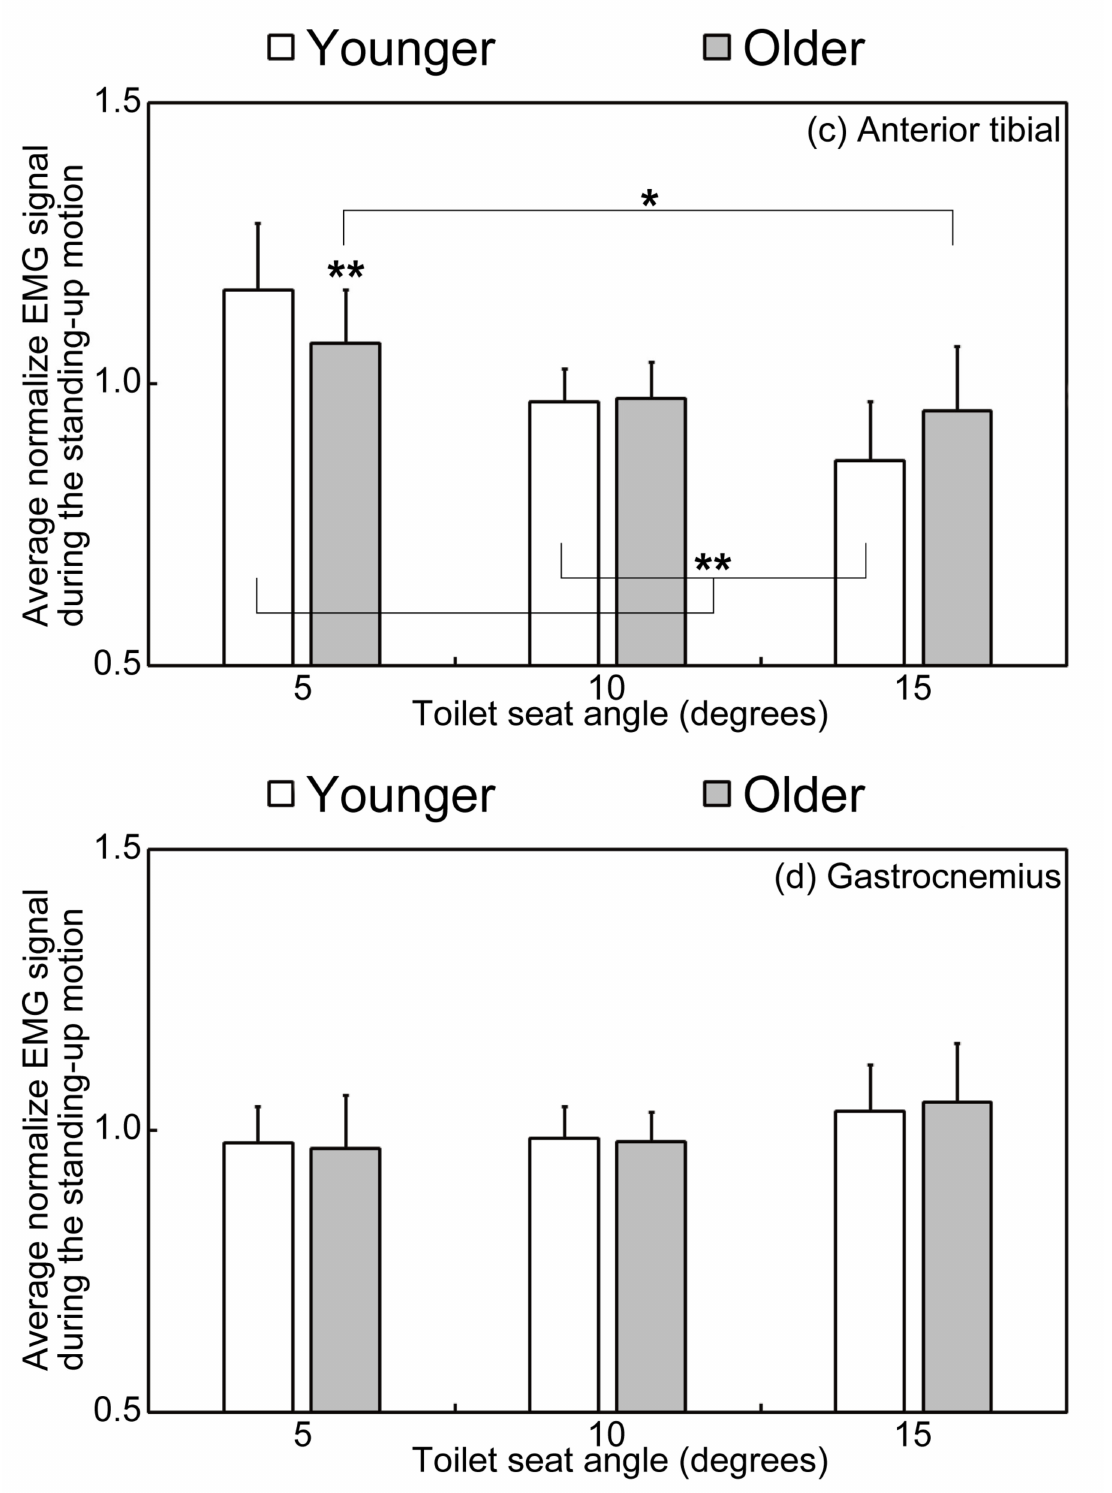
Figure 7. Comparison of average peak EMG amplitudes during the standing-up motion according to toilet seat angle. ( a ) Erector spinae; ( b ) rectus femoris; ( c ) tibialis anterior; and ( d ) gastrocnemius. Vertical lines denote the standard error of the mean. Brackets indicate a statistically significant difference (based on the Bonferroni test) by toilet seat angle. Asterisks indicate a statistically significant difference (based on the Bonferroni test) between younger and older participants. Bonferroni multiple comparison test (**) p < 0.01, and (*) p <